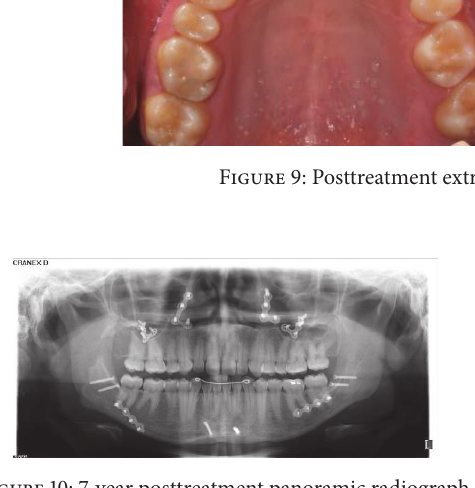
Figure 10: 7-year posttreatment panoramic radiograph.